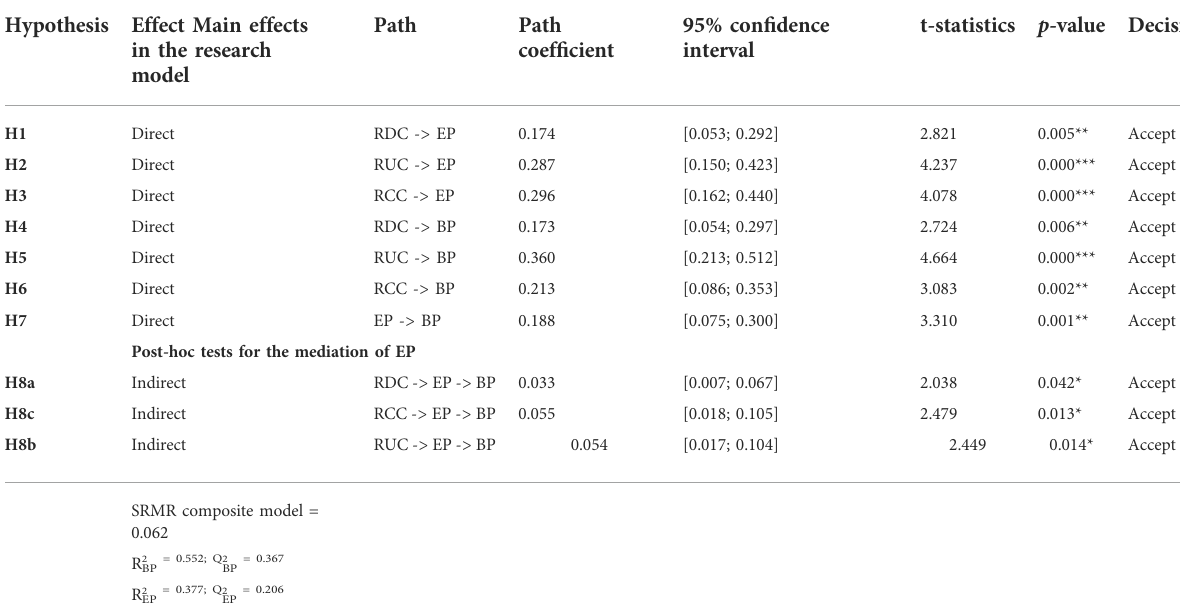
TABLE 4 Results of hypothesis